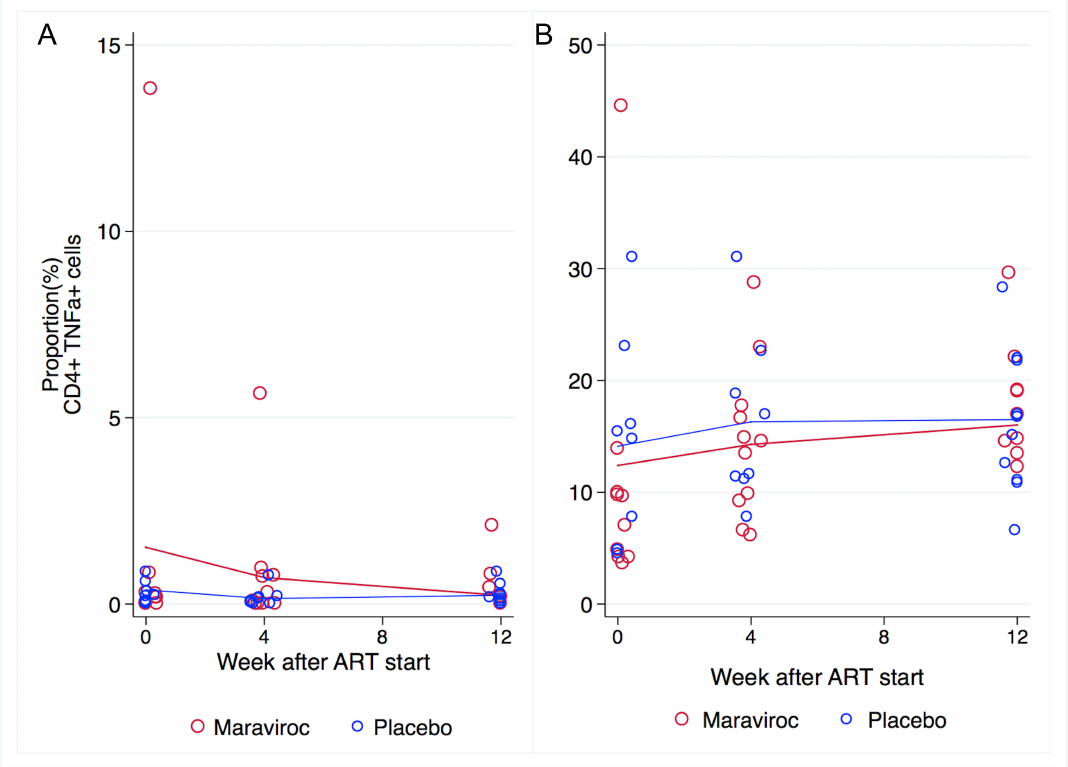
Supplementary Figure 2. Proportion of CD4 lymphocytes expressing TNFa upon exposure to CMV peptides and